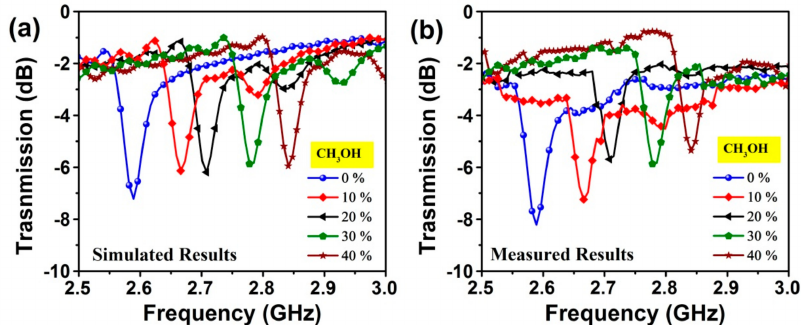
Figure 15. E ff ect of methanol (CH 3 OH) concentration on the transmission coe ffi cient over 2.5- 3 GHz: ( a ) simulated; ( b ) measured results.